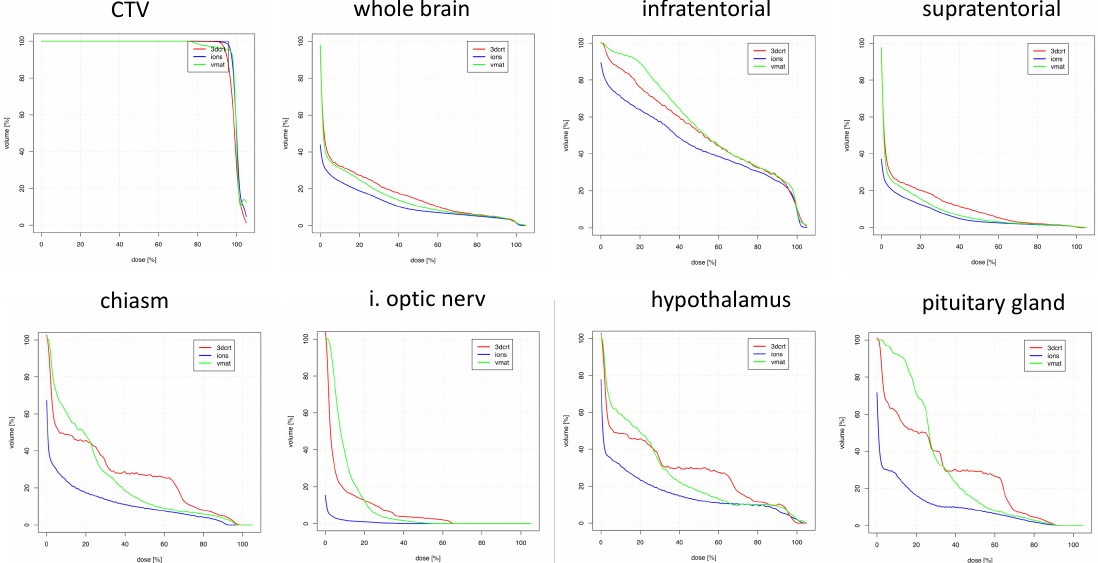
Figure 5. Dosimetric comparison: clinical target volume coverage and dose volume histogram curves of the organs-at-risk in patients with tumor localization in the posterior cranial fossa. Curves demonstrate median dose values of all patients with posterior cranial fossa tumor localization. Intensity-modulated proton therapy (IMPT/PRT; blue line) vs. volumetric-modulated arc therapy (VMAT; green line) vs. three-dimensional conformal radiotherapy (3DCRT; red line). CTV: clinical target volume; i.: